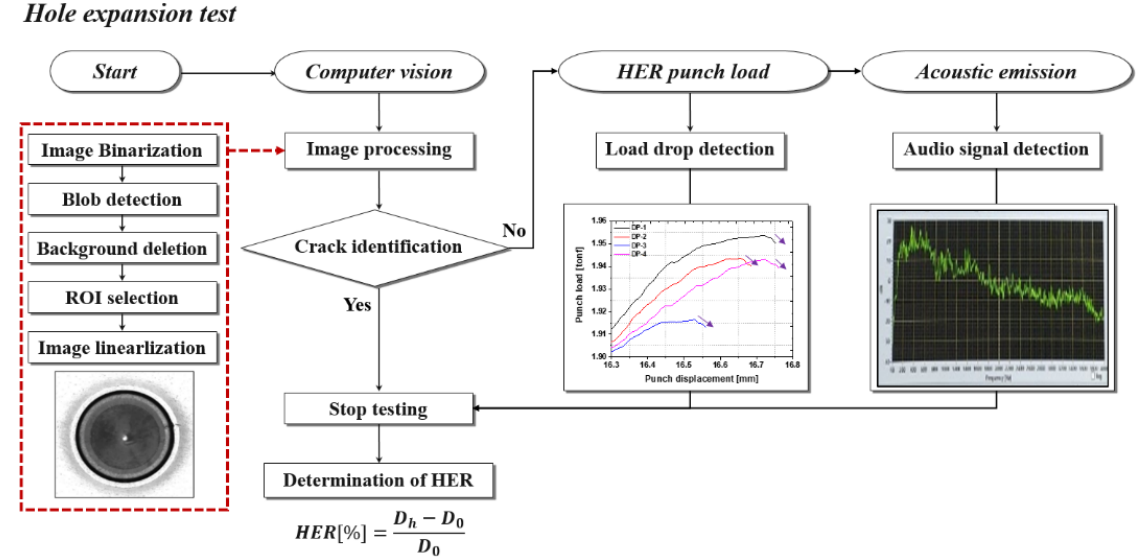
Figure 3. Measurement procedure of HER with various kinds of analysis system.